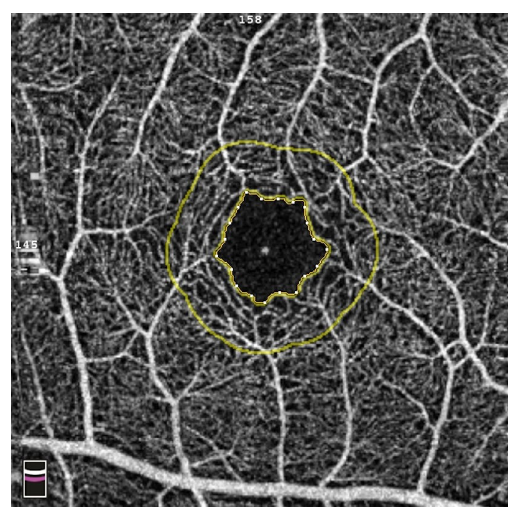
Figure 2. Definition of the macula/fovea/parafovea areas from en face OCTA images using OCTA AngioAnalytics software. En face OCTA images representing the areas (shaded in yellow) corresponding to ( A ) the 3 mm-diameter macular area, ( B ) the central 1 mm-diameter circular area of the fovea, ( C ) the parafovea. Images were created using Preview Version 10.1 (944.6.16.1) (https:// suppo rt. apple. com/ guide/ previ ew/ welco me/ mac), and Fiji Version 2.0.0-rc-69/1.52p (https:// imagej. net/ softw are/ fiji/).